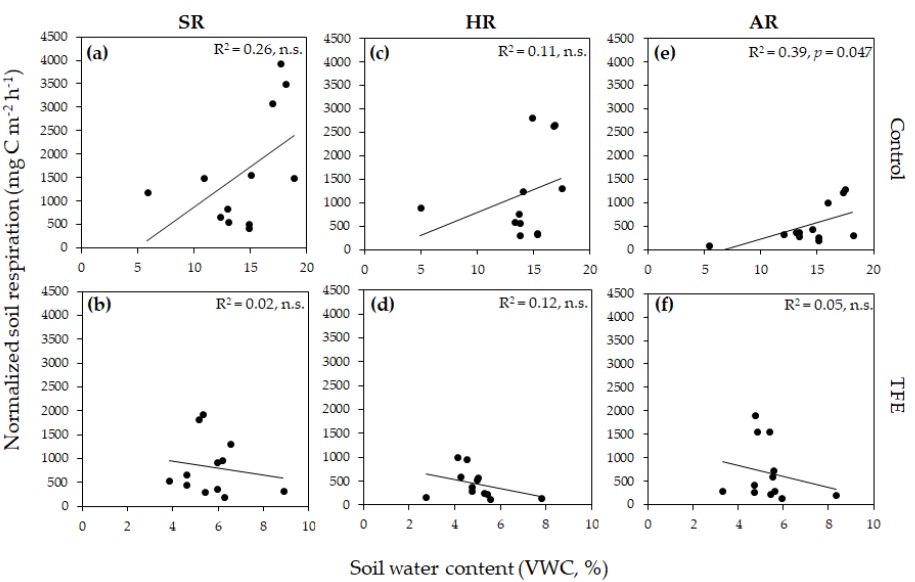
Figure 5. Soil temperature dependency of ( a , b ) total soil respiration (SR), ( c , d ) heterotrophic soil respiration (HR), ( e , f ) autotrophic soil respiration (AR) in control and throughfall exclusion (TFE) plots. Exponential function is 𝑦 = 𝛽 0 × exp(𝛽 1 ∙ 𝑥) ; y is measured soil respiration ( R S ), x is soil temperature and 𝛽 0 and 𝛽 1 are fitted parameters. Q 10 function is 𝑄 10 = exp (10 ∙ 𝛽 1 ) . R 2 is coefficient of determination and p represents p -value.